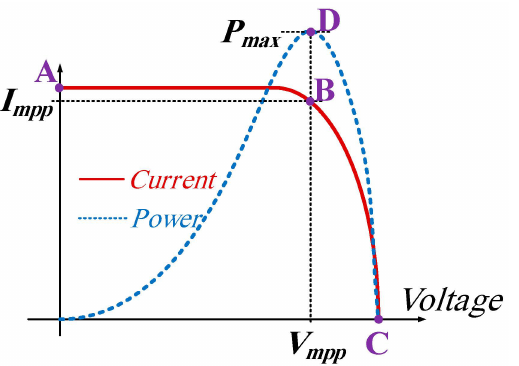
Figure 18. Current-voltage (I–V) and power-voltage (P–V) curves of a photovoltaic module.